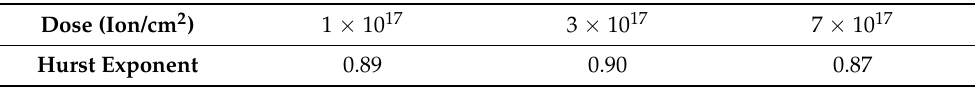
Figure 6. The normalized height distributions of ( a ) unimplanted sample, ( b ) implanted sample 2, ( c ) implanted sample 3 and ( d ) implanted sample 4. Table 5. The Hurst exponent of implanted